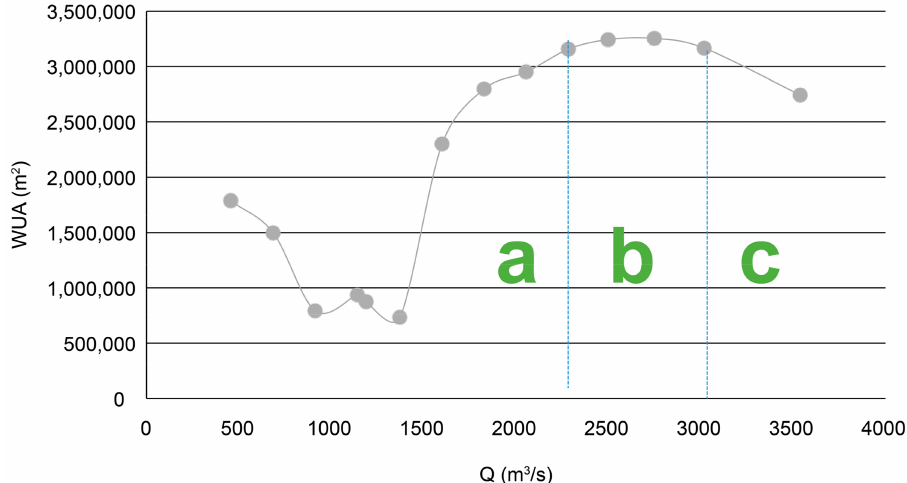
Figure 13. WUA-Q curve for the study area.